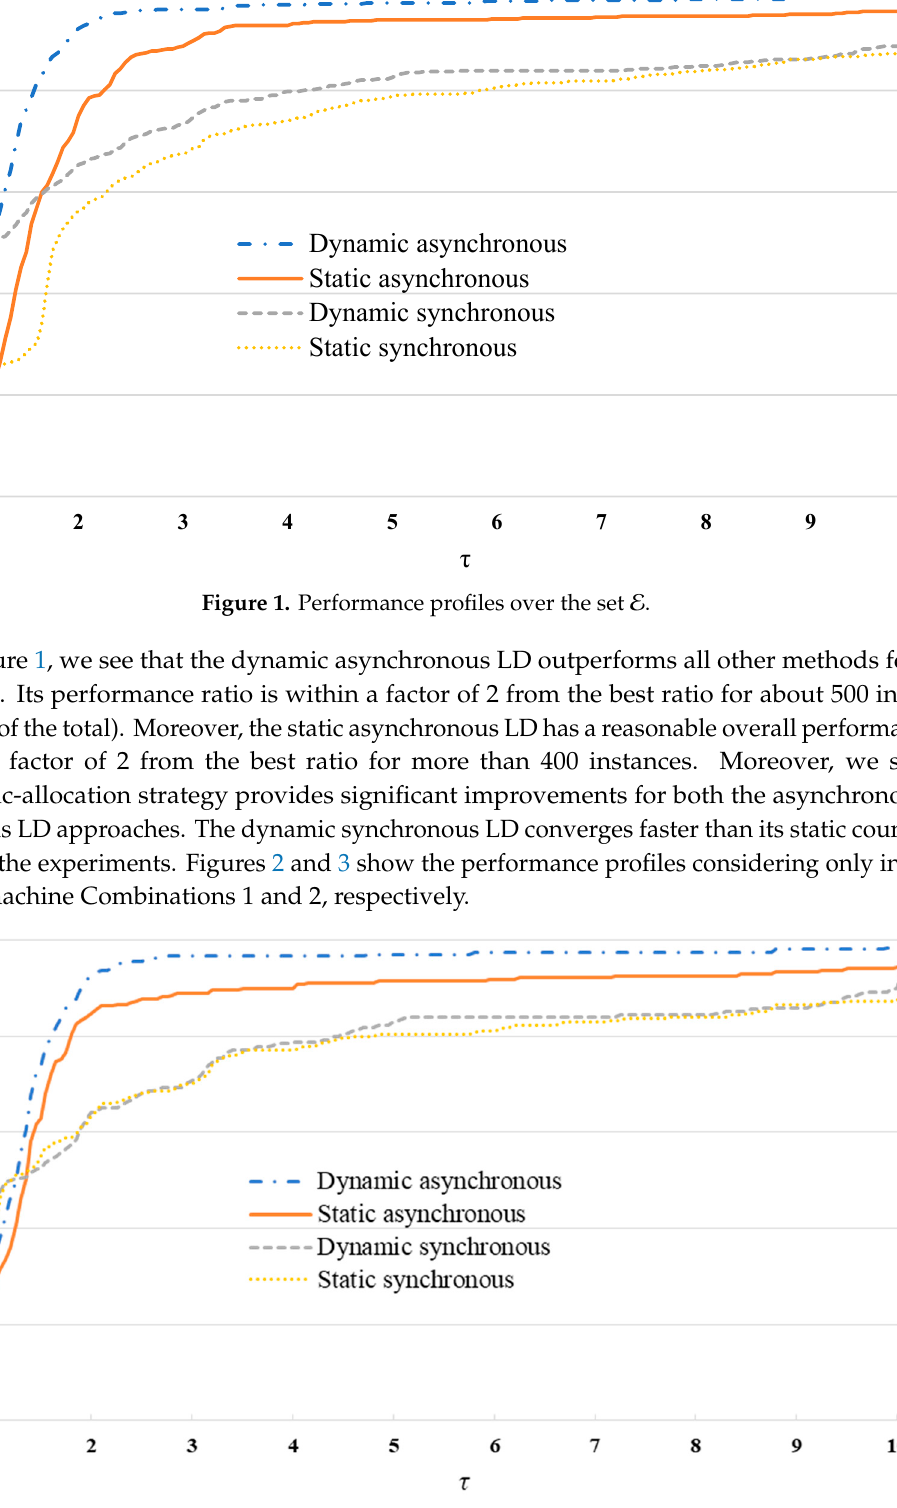
Figure 2. Performance profiles for the instances with machine Combination 1.